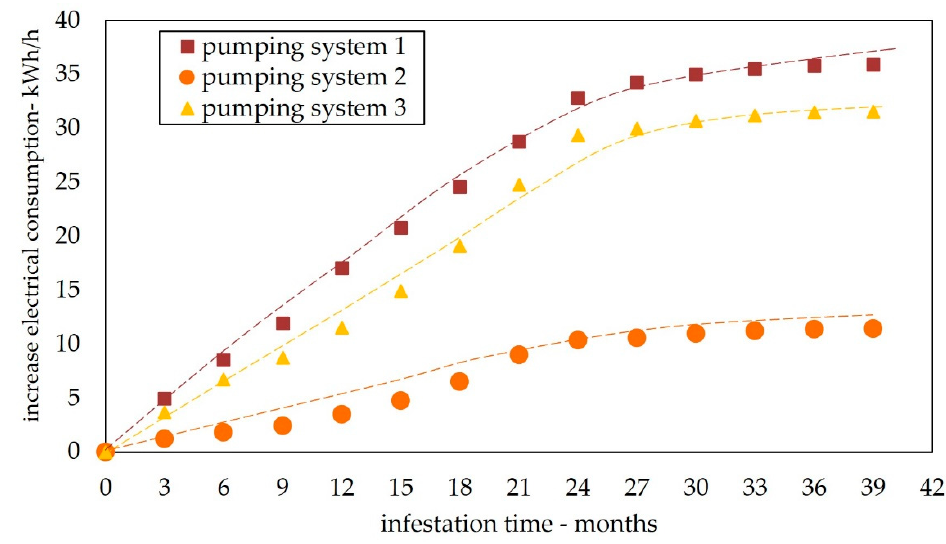
Figure 7. Increase in consumption in kilowatt hours (kWh) for each pump of the Elevated Pumping Station (EPS) of Rio Branco, after the beginning of the golden mussel (GM) bioinfestation, based on the data from Tables 4–6, and in view of the operating time, given in months.